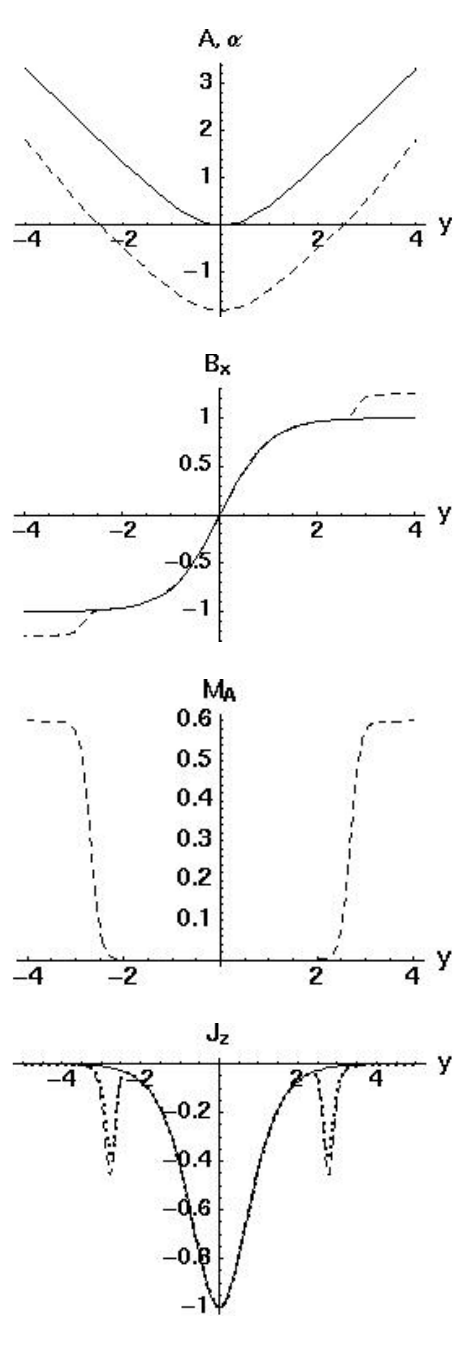
Fig. 5. From top to bottom we show the flux-functions A(y),α(y) , the magnetic field B x (y) , the Alfv´en Mach number M A (y) and the electric current density j z (y) . Solid lines correspond to the mag- netostatic case and dashed lines to stationary MHD with the pro- file (29) and M 1 = 0, M 2 = 0 . 5, A c = 2 and d = 5. In the bottom panel we show additional dotted the approximation for M A (cid:28) 1 as computed with Eq.